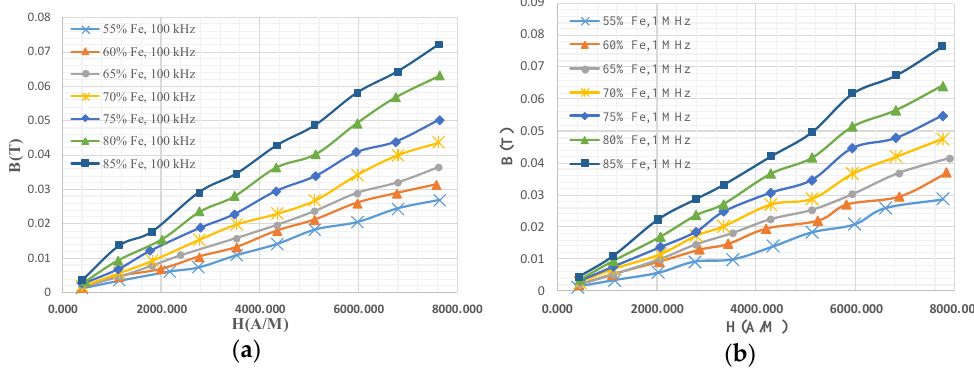
Figure 9. Graph with different values of B and H: ( a ) operating at a 100 kHz switching frequency, ( b ) operating at a 1 MHz switching frequency.